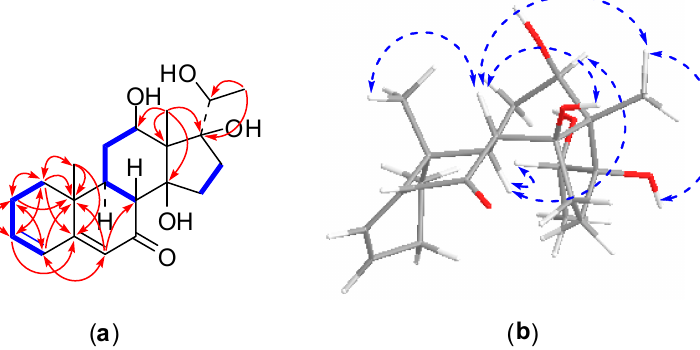
Figure 3. 2D NMR correlations of compound 2 : ( a ) 1 H- 1 H correlations (bold lines) and selected HMBC correlations (arrows); ( b ) selected NOSEY correlations.